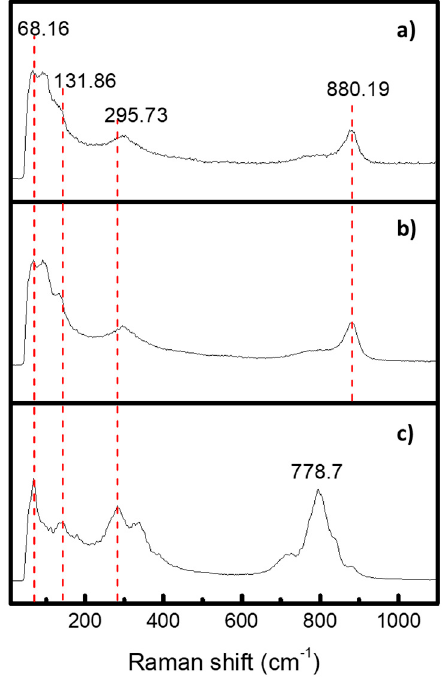
Figure 8. Raman spectra of ( a ) MBR2; ( b ) MBR1; and ( c ) Bi 2 MoO 6 compounds.